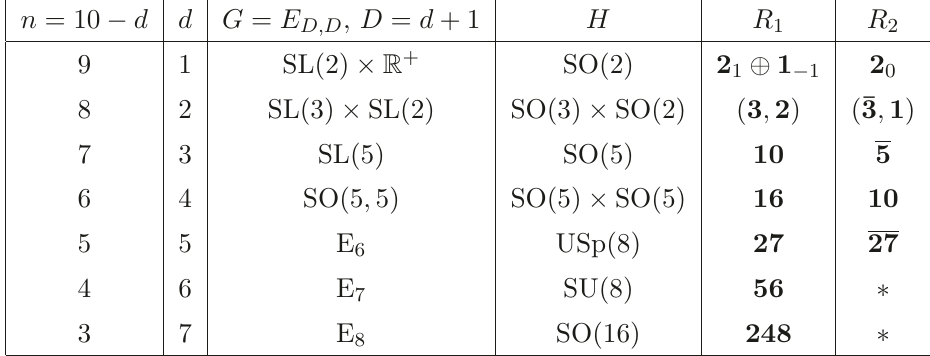
Table 1 . Generalised diffeomorphism groups and tensor hierarchy representations for EFT. n is the external dimension while d is the internal dimension from the point of view of type II